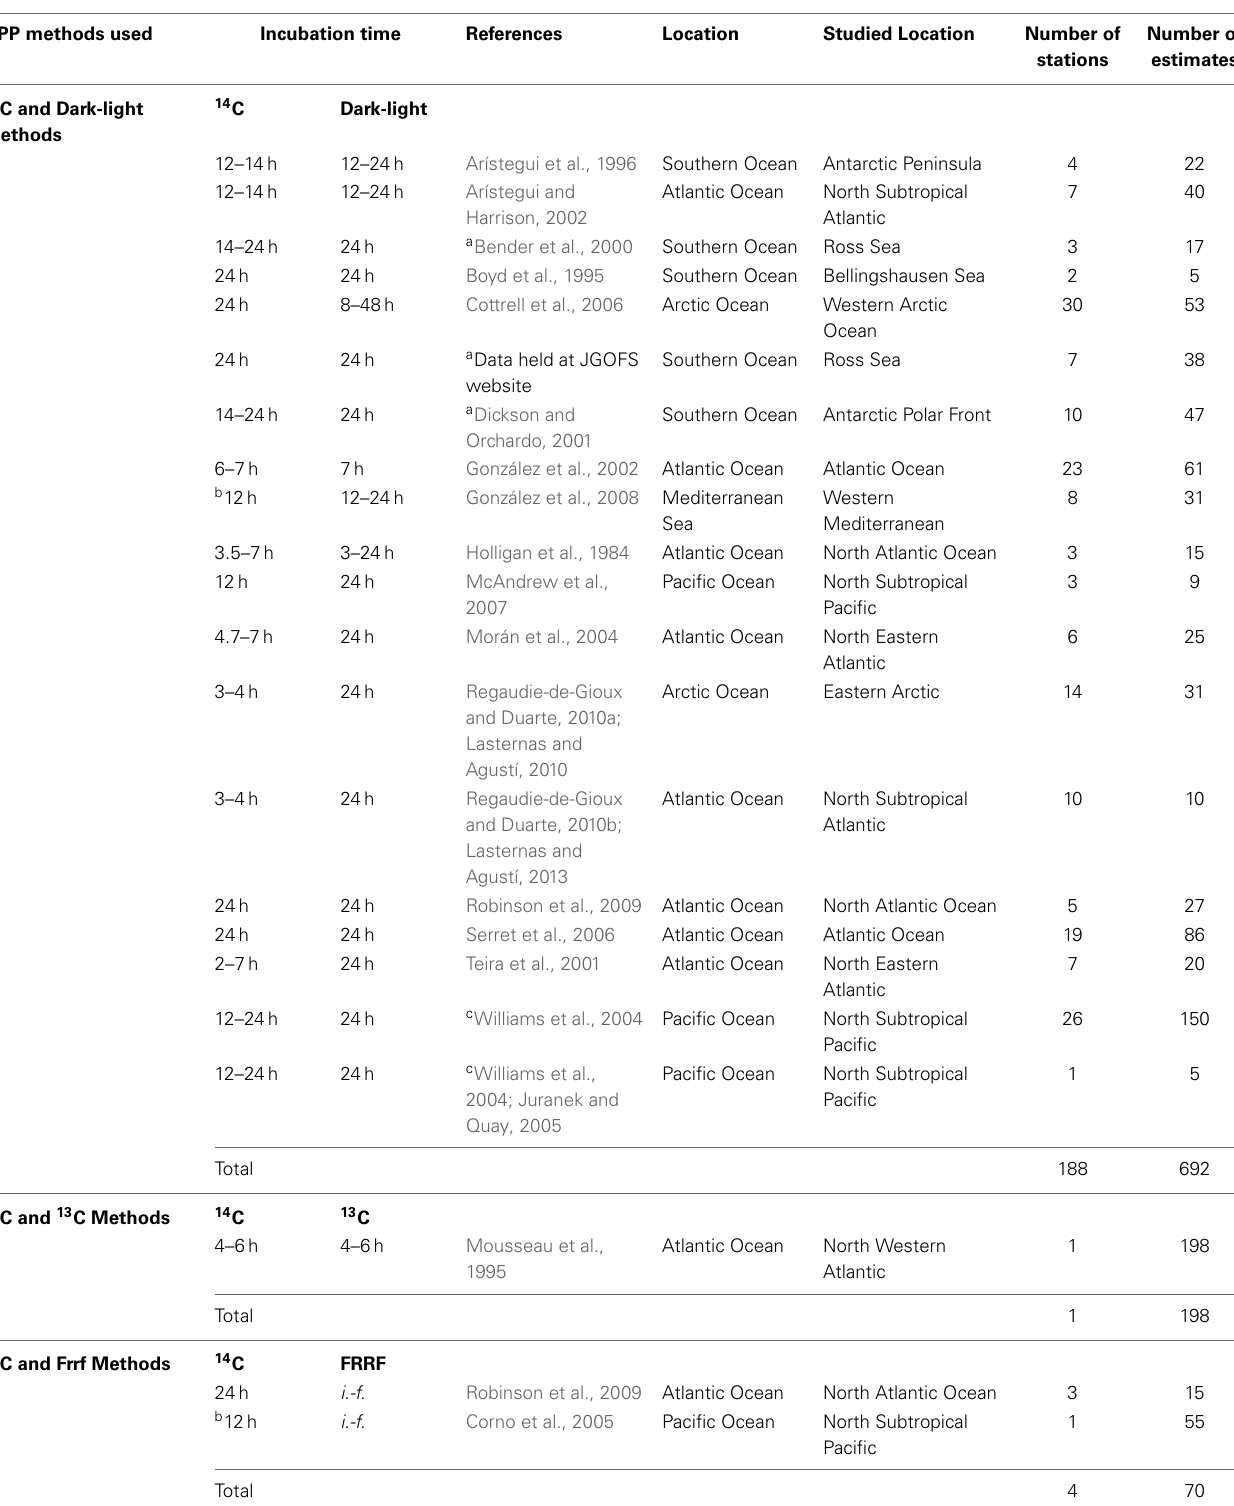
Table 2 | Incubation period, references, description of the location, number of stations and of estimates of the different studies analyzed here measuring GPP rate by two different